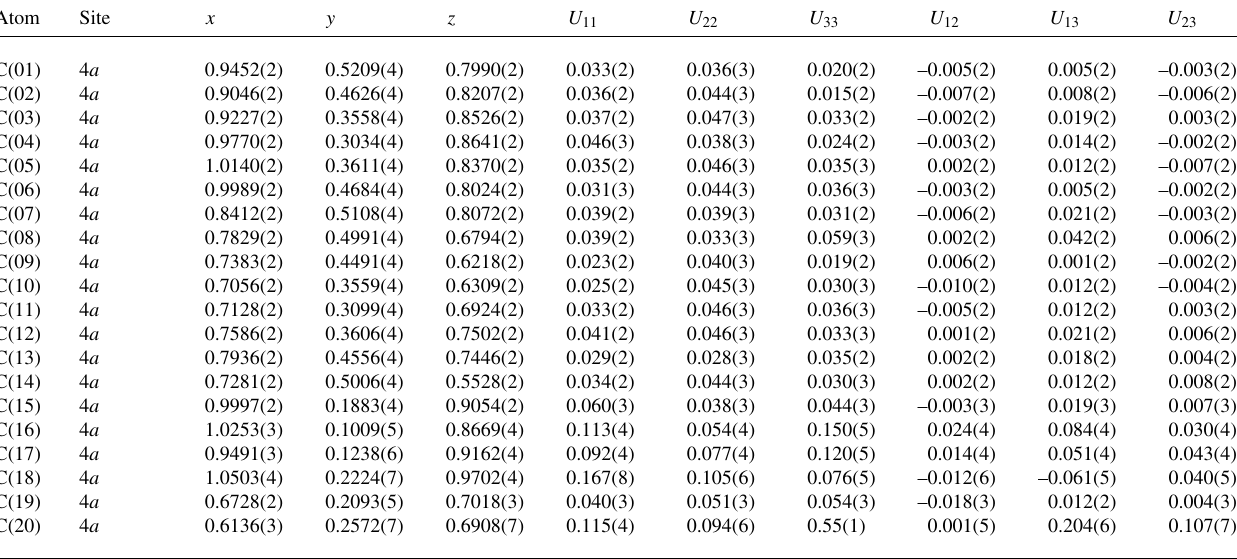
Table 3. Atomic coordinates and displacement parameters (in Å 2 ) .